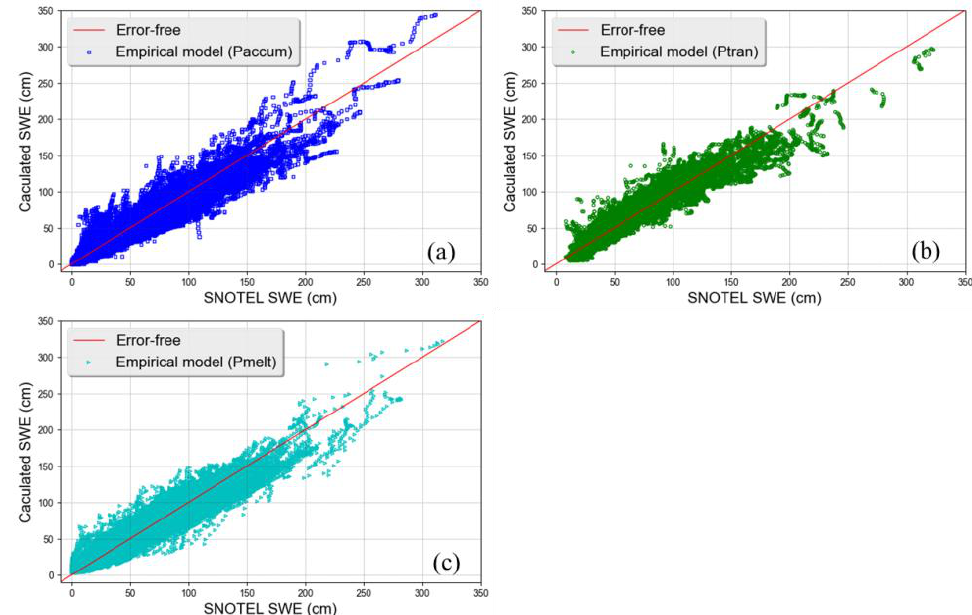
Figure 10. Scatterplot of the in situ SWE versus the modeled SWE estimates for Paccum ( a ), Ptran ( b ) and Pmelt ( c ). Table 4. Mean, STD and RMS of the errors for the developed empirical model-based SWE estimation. Period Mean (cm) STD (cm) RMS (cm) Paccum −